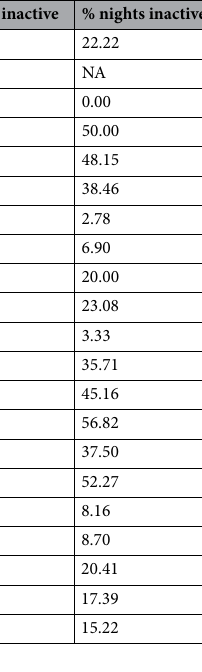
Table 1. Periods of inactivity in the nest in 20 desert hedgehogs radio-tracked overwinter in 2010–2011 and 2011–2012. “–” = Hedgehog was never inactive for a full night, “NA” = not enough data (the animal was last successfully radio-tracked on 07 January 2012 before the tag fell off) “Ongoing” = Hedgehog still inactive at end of tracking period (25 February 2012). *One or more nights inactive and in the nest. † Last night of inactivity during the tracking period.